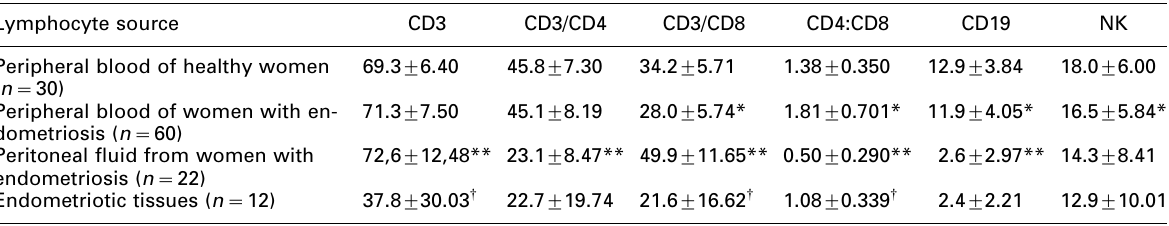
Table 3. Distribution of lymphocyte subpopulations in women with